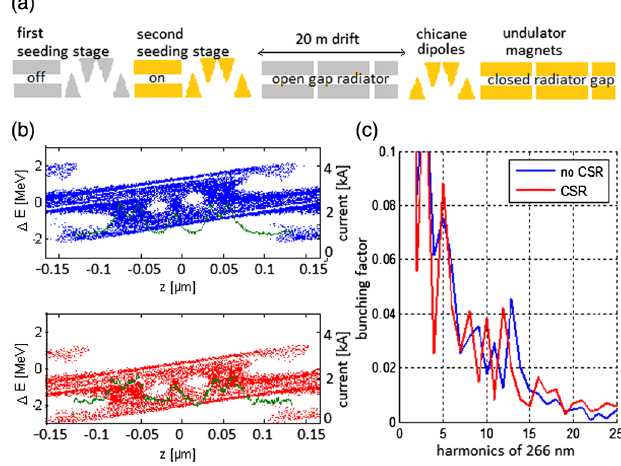
FIG. 10. The EEHG/HGHG scheme proposed in [18,57] in which the EEHG-seeded radiation from the first radiator stage seeds a second radiator stage (a). The harmonic content of a 20 nm seeded beam with (red) and without (blue) CSR from a 100 μ m dispersion chicane with bend radii of 13 m. A single cycle of the longitudinal phase space distribution and current distribution are plotted in (b). The seed wavelength was 266 nm and the dispersion in the first chicane was 1 mm. The initial peak current was 1.5 kA, the electron beam energy was 700 MeV, and the initial slice energy spread was 150 keV (rms).